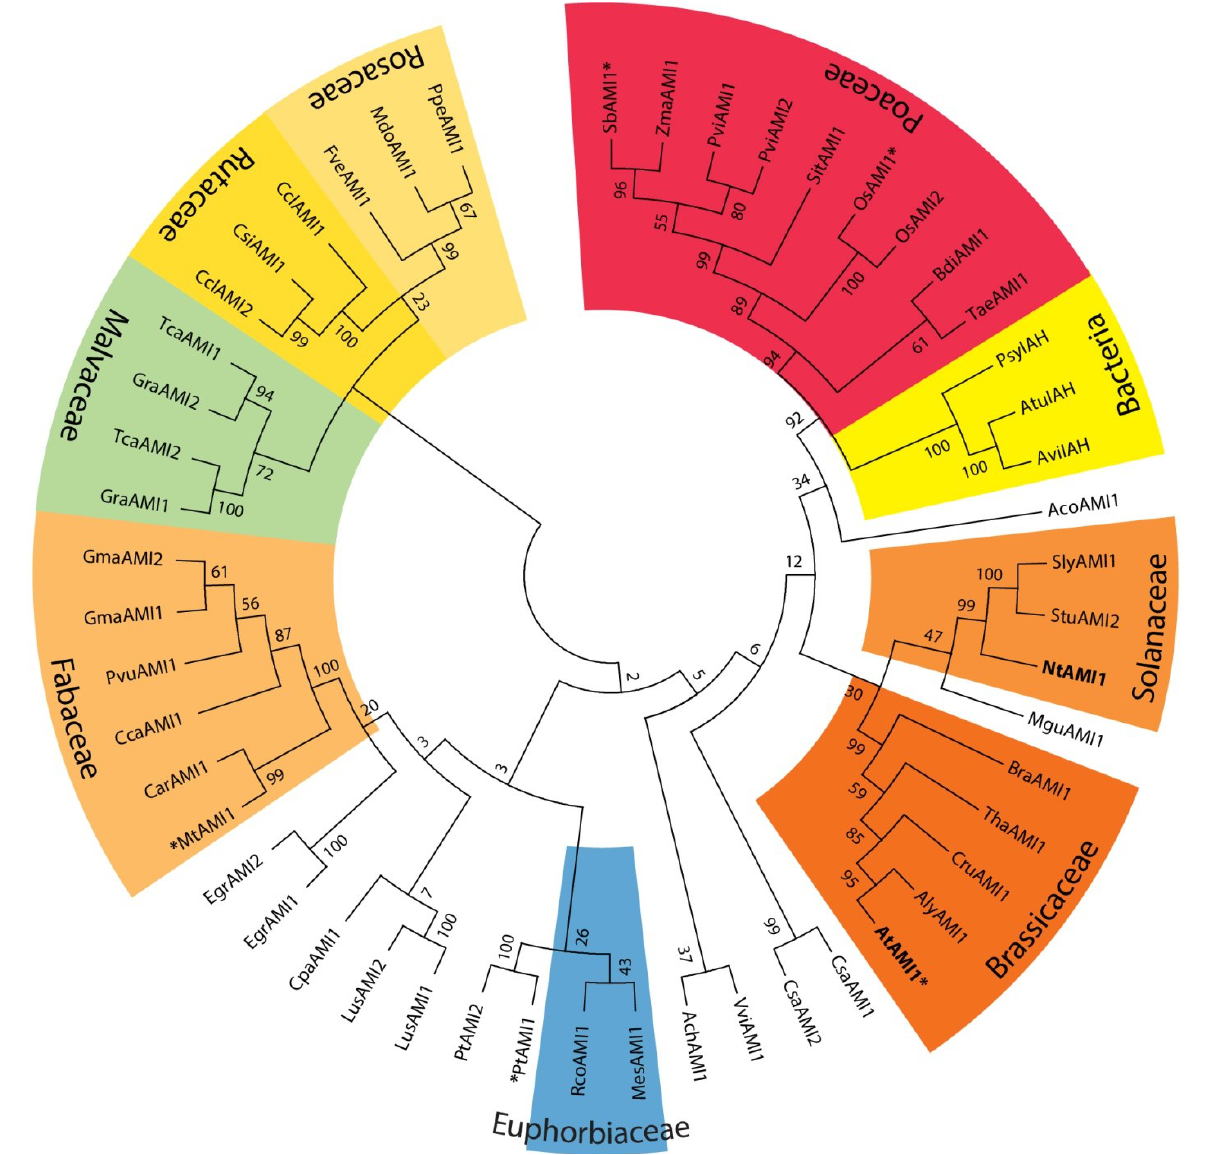
Figure 2. Cladogram of 51 AMI1-like proteins from plants and